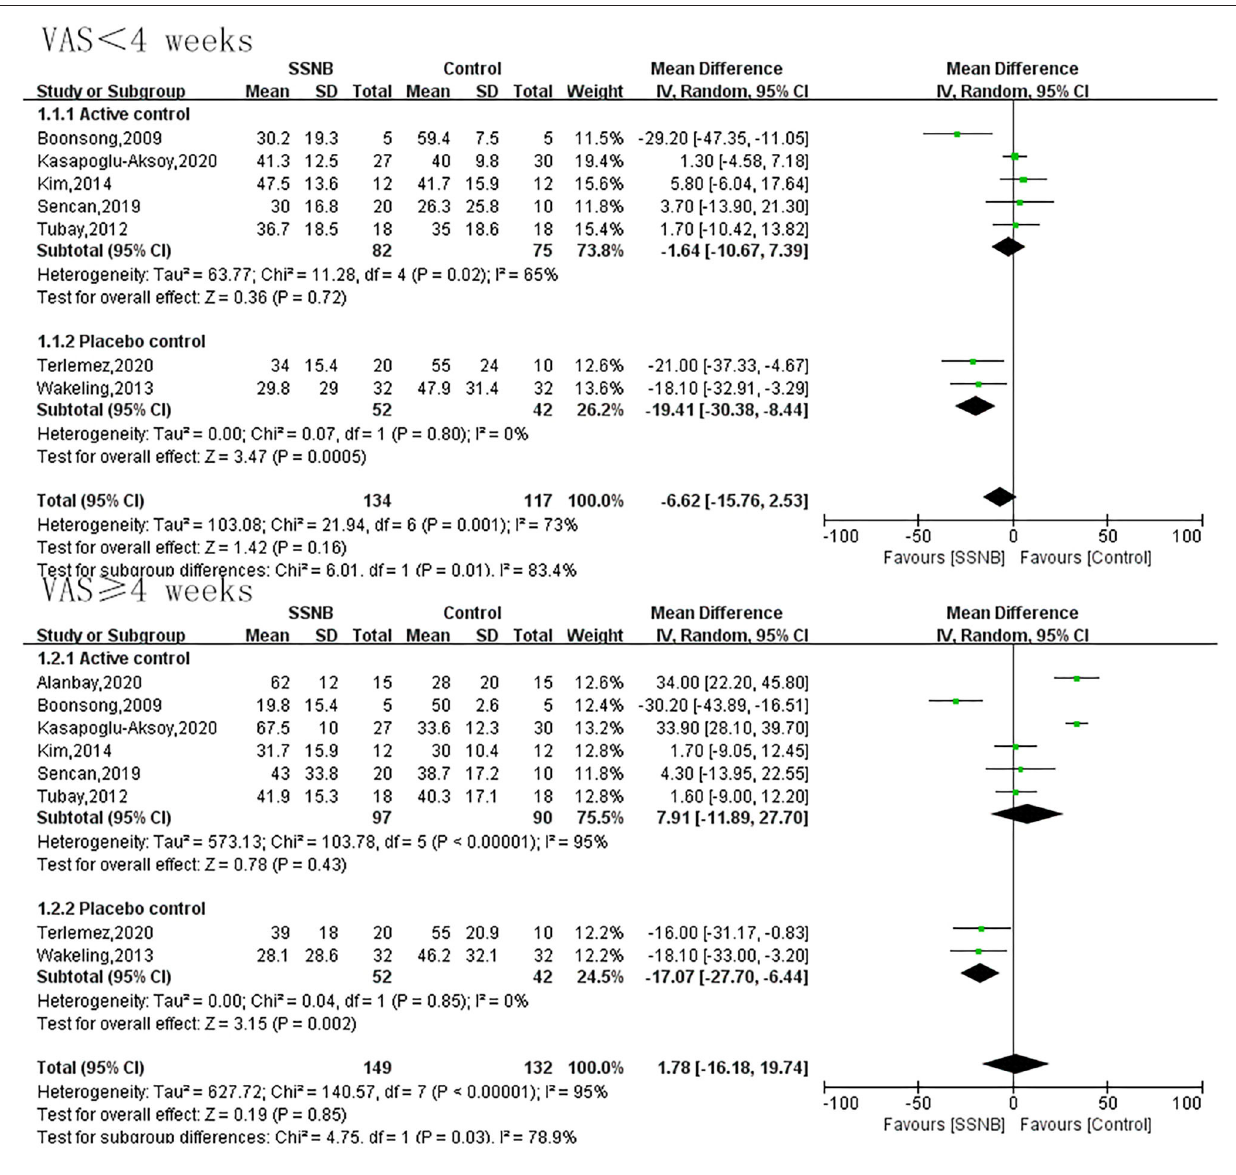
FIGURE 2 | Forest plot of VAS between SSNB and other